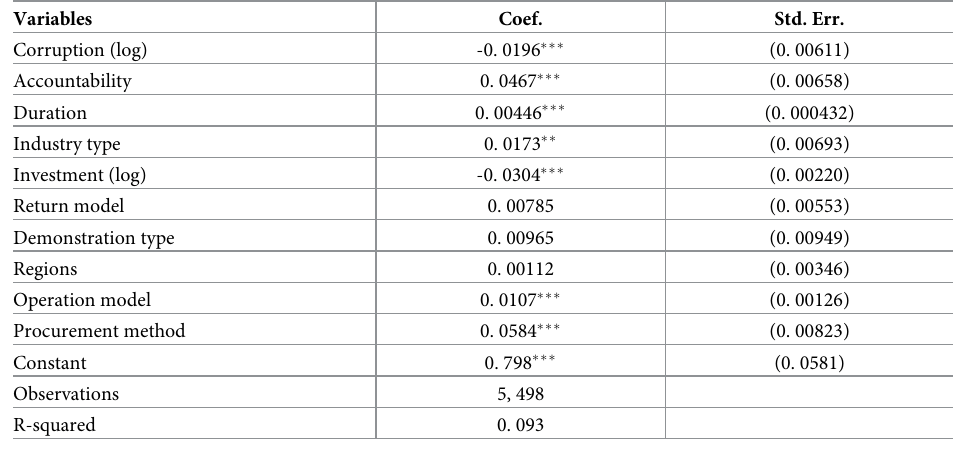
Table 5. Regression results with reduced sample size.